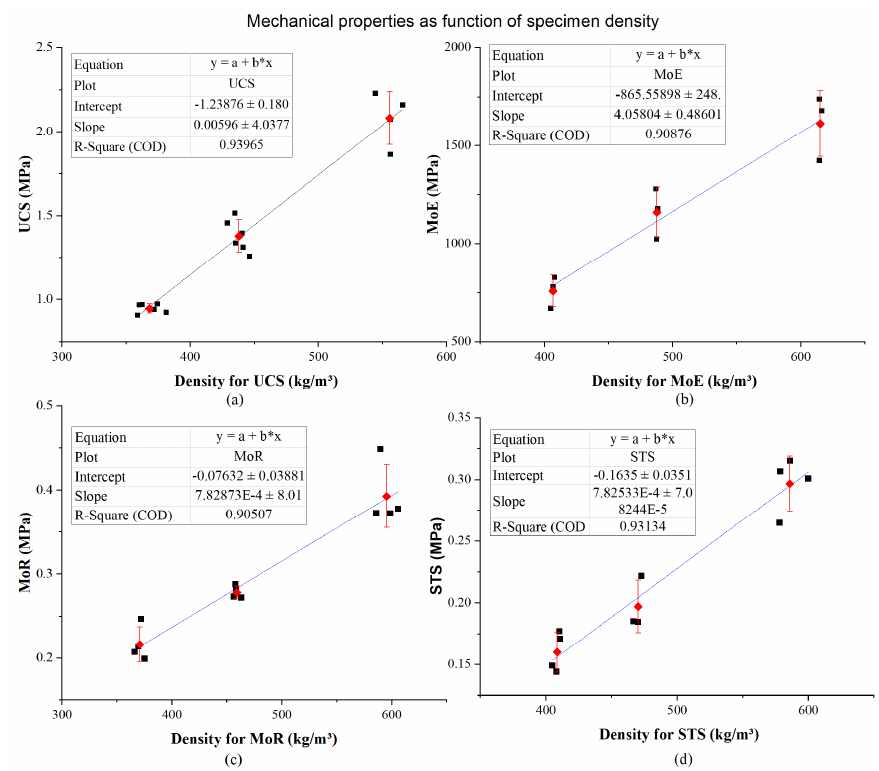
Figure 13. Mechanical properties as function of specimen density. ( a ) UCS as a function of specimen density. ( b ) MoE as a function of specimen density. ( c ) MoR as a function of specimen density. ( d ) STS as a function of specimen density.